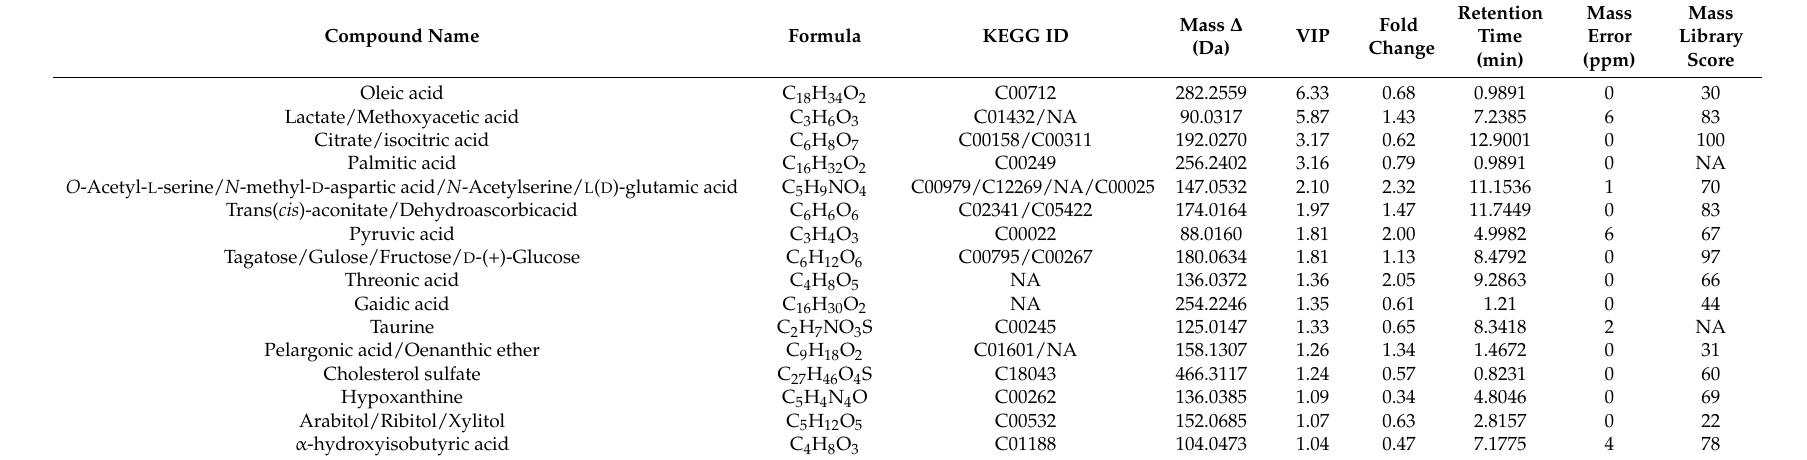
Table 2. Potential serum biomarkers of